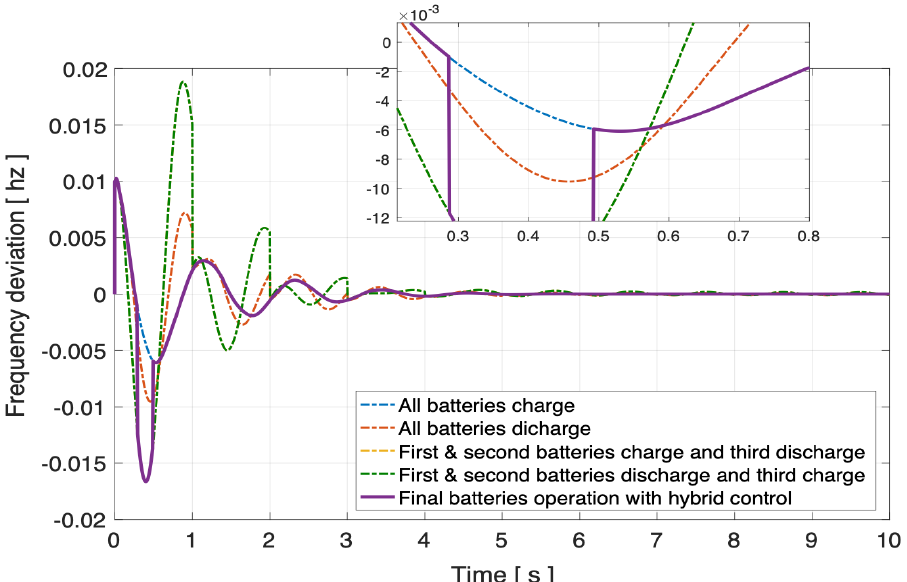
Figure 7. Frequency deviations of the generator number five in the third area for different scenarios and hybrid control final decision.